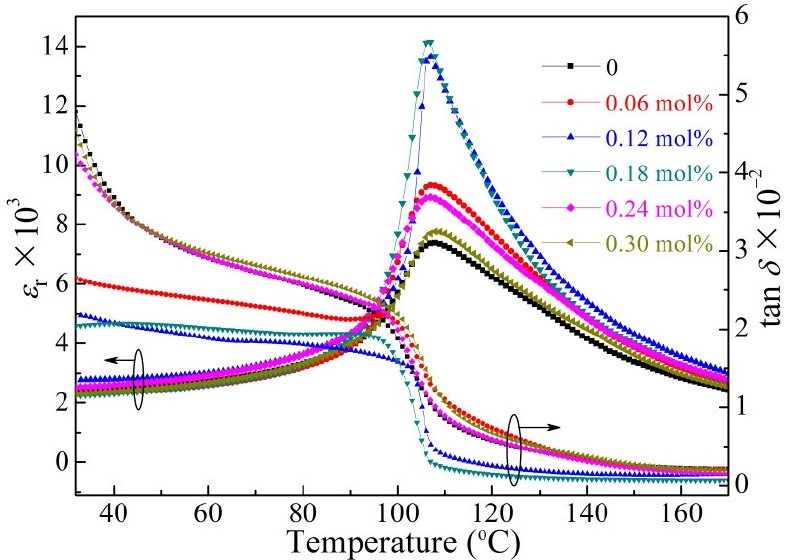
Figure 3. Loss tangents (tan δ ) ( ε r ) and relative permittivities of the BCTZ-NY x ceramics with different yttrium contents at 10 kHz.